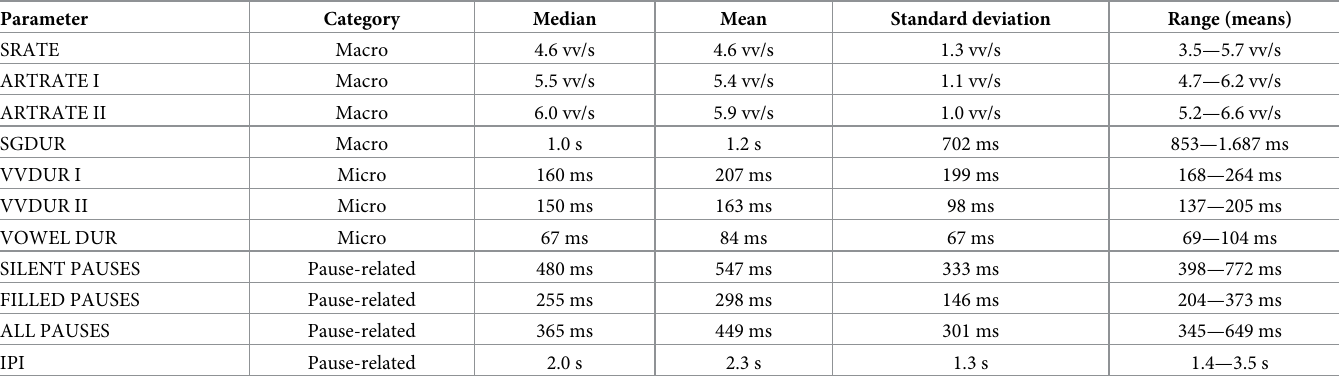
Table 1. Parameters’ categories followed by median, mean, standard deviation and range (of individual means) across subjects.